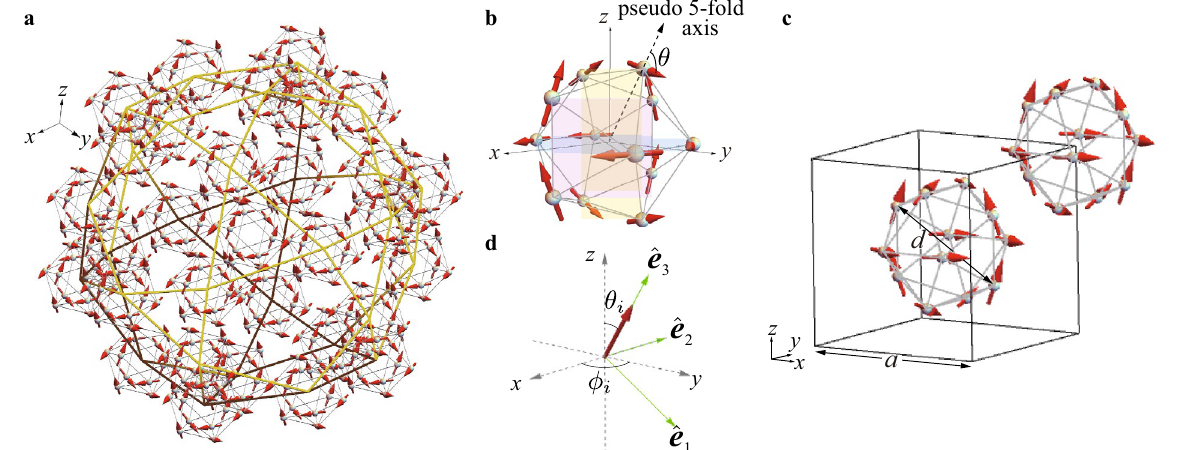
Figure 1. ( a ) FM long-range order of the ferrimagnetic state in the QC. The magnetic moments at the 12 vertices of the IC located at the vertices of the icosidodecahedron and also at the center. Green (brown) lines connect the vertices of the icosidodecahedron in the front (back) side. ( b ) The ferrimagnetic state in the IC. The vector passing through the Tb site from the center of the IC is the pseudo 5-fold axis drawn as the dashed line with an arrow, which is in the mirror plane colored by yellow surface. The same is applied to each Tb site where the mirror planes are colored by pink and light blue surfaces. The direction of the magnetic moment is defined 80 as the angle θ from the pseudo 5-fold axis. The θ ◦ case is illustrated. ( c ) In the 1/1 AC, the ferrimagnetic = 80 state for θ ◦ on the IC is located at the center and corner at the bcc unit cell with a being the lattice constant = 14.726 Å. ( d ) Local coordinate introduced at each Tb site where e 3 is set to be the unit vector along the a ˆ = e 1 and e 2 are orthogonal unit vectors each other (see “Methods” section). direction of the magnetic moment and ˆ ˆ The polar angle at the i th Tb site is defined as (θ i , φ i ) in the global xyz coordinate. (This figure is created by using Adobe Illustrator CS5 Version